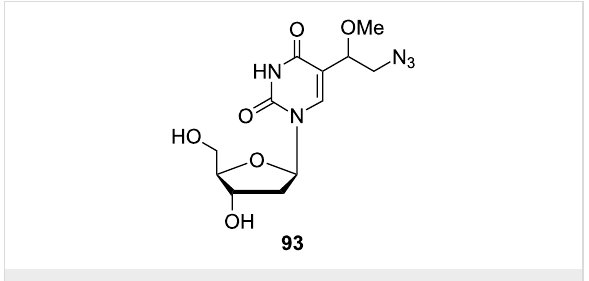
Figure 16: 5-(1-Methoxy-2-azidoethyl)-2'-deoxyuridine ( 93 ).